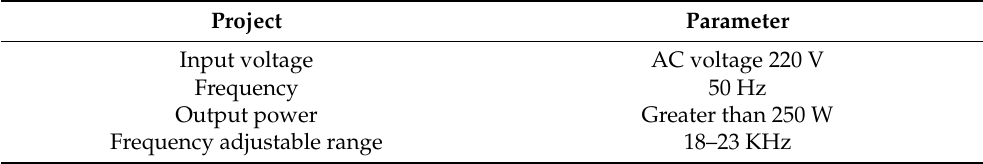
Table 2. Performance parameters of the SZ12 ultrasonic frequency generator.